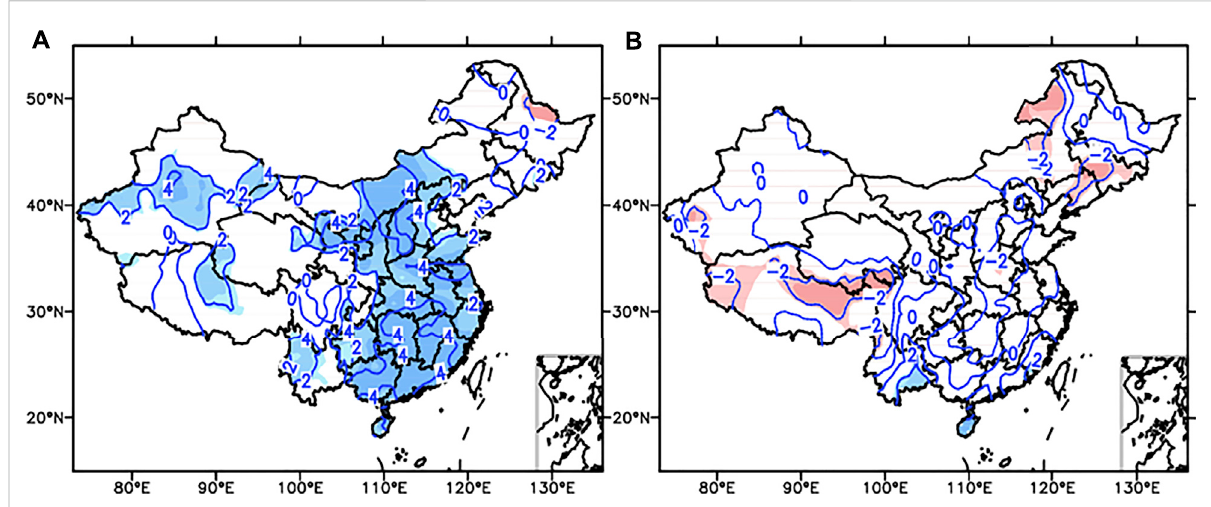
FIGURE 6 The t -testresultsofthe (A) precipitationand (B) temperaturedifferenceinChinabetweenthestronger andweakerwinterFATyears.(Solidlines anddashedlinesrepresentpositiveand negativevaluesrespectively;correlationsigni fi cantatthe0.01,0.05and0.1con fi dencelevel areshadedwith dark and light grey, contour interval: